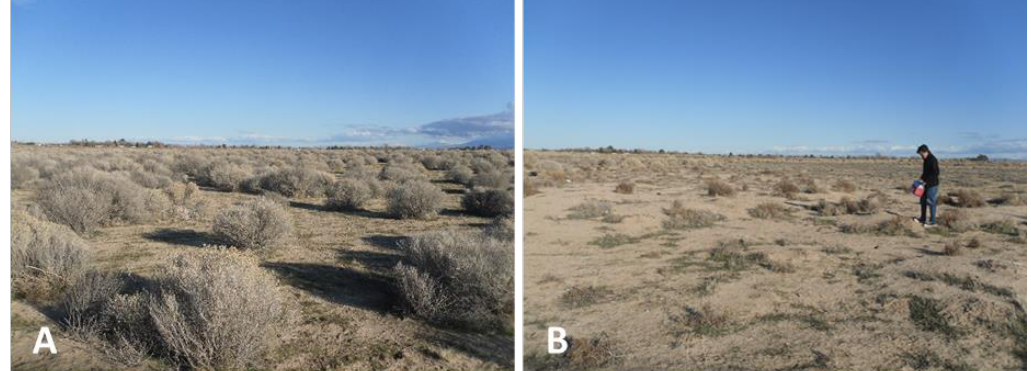
Figure 13. Sites 5 ( A ) and site 6 ( B ) west of Antelope Acres and EAFB where C. immitis DNA was detected, with scattered common rabbit brush and Salt Bush. Site 6 showed increased disturbance and erosion compared to site 5.